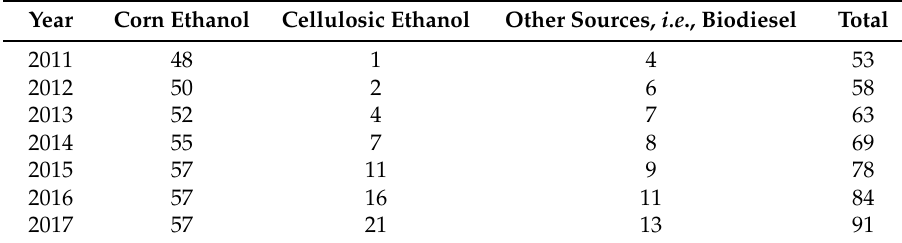
Table 1. ESIA annual ethanol mandates (billion